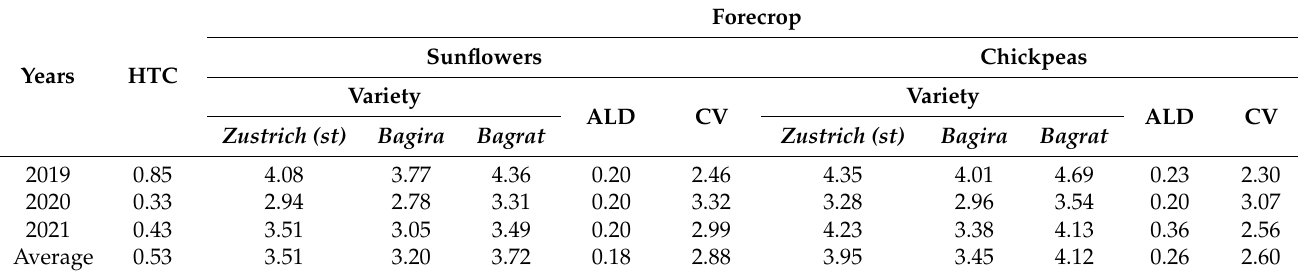
Table 7. Effect of HTC on yield of winter wheat varieties,